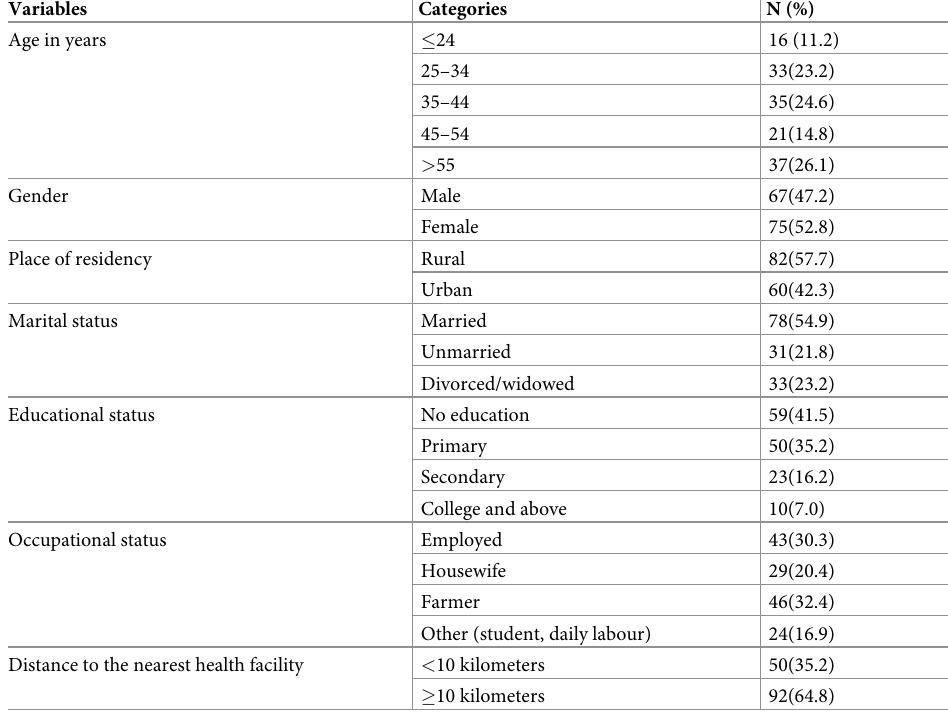
Table 1. Sociodemographic characteristics of EPTB patients at public health facilities of North Shewa zone, Ethio- pia, April